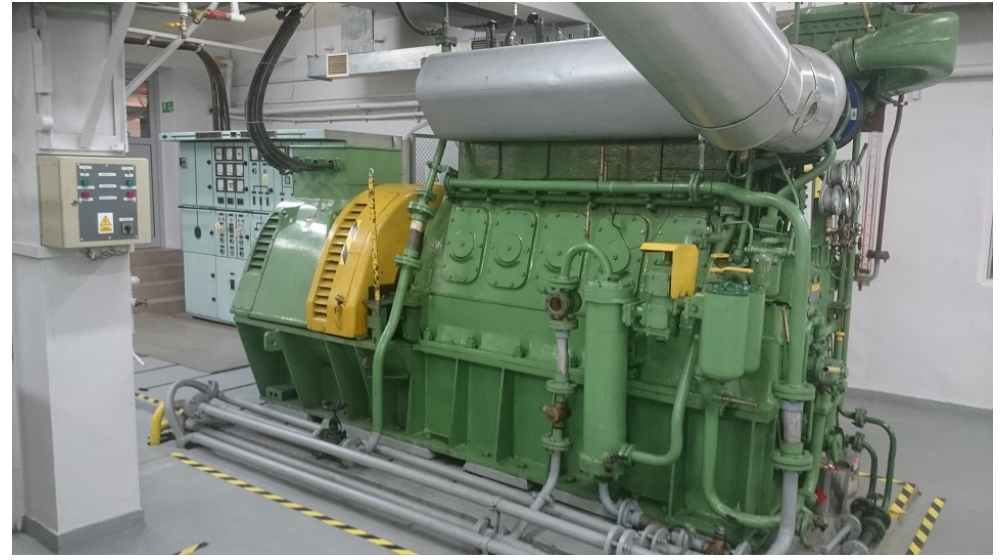
Figure 2. View of the analyzed Sulzer 5 BAH 22 engine.